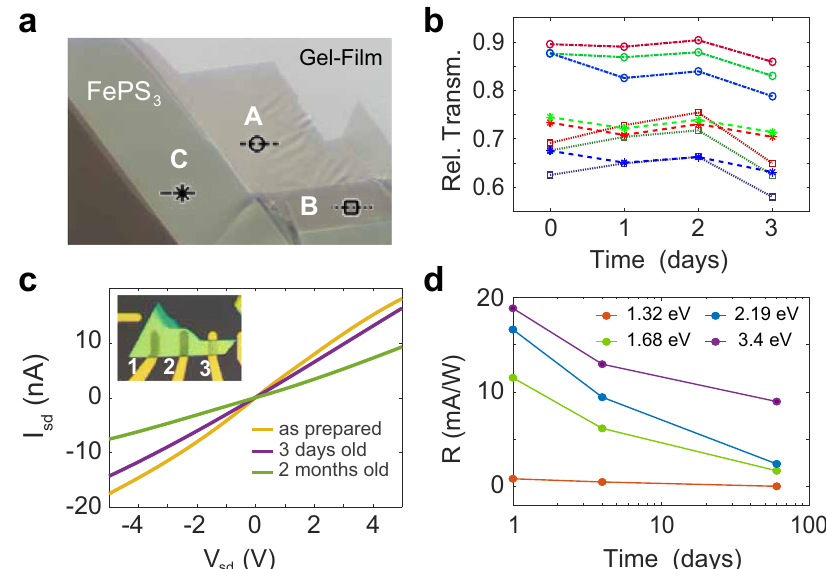
Fig. 5 Time evolution of the optoelectronic properties. a Transmission optical microscope image of FePS 3 exfoliated fl ake onto a Gel-Film polymeric substrate. The white scale bar represents 10 μ m. Three zones ( A – C ) with an estimated thickness of 15, 30, and 85 nm, respectively, are selected for transmission measurements over time. b Flake transmission relative to the substrate at the A – C zones labeled in panel ( a ) for the R, G, and B CMOS channels. c I – V characteristics of the same 30-nm thick FePS 3 fl ake presented in Fig. 2 as a function of time. Two-terminal measurements were performed between contacts 1 – 2, as labeled in the fl ake image in the inset. d Time evolution of the device responsivity as a function of energy.